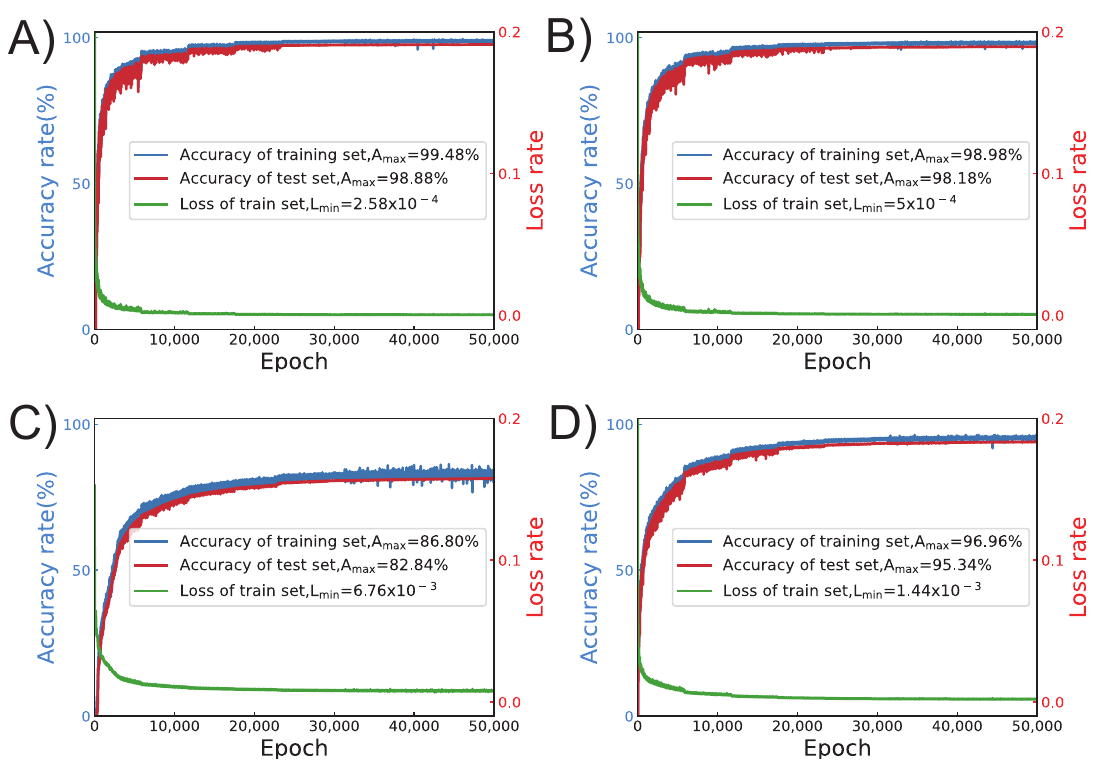
Figure 4. The training curve of the proposed ANN using four different activation functions. ( A ) Leaky ReLU function. ( B ) ReLU function. ( C ) Sigmoid function. ( D ) Tanh